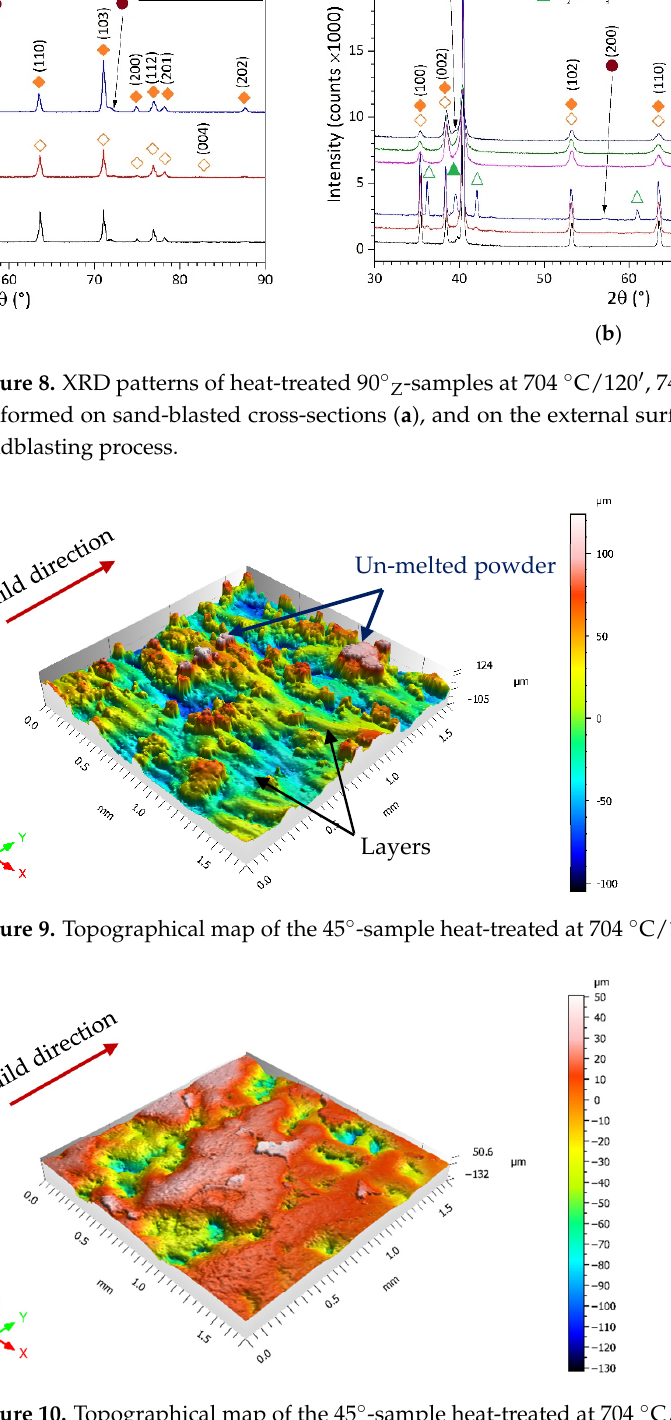
Figure 10. Topographical map of the 45°-sample heat-treated at 704 °C/120 ′ after the SB process.